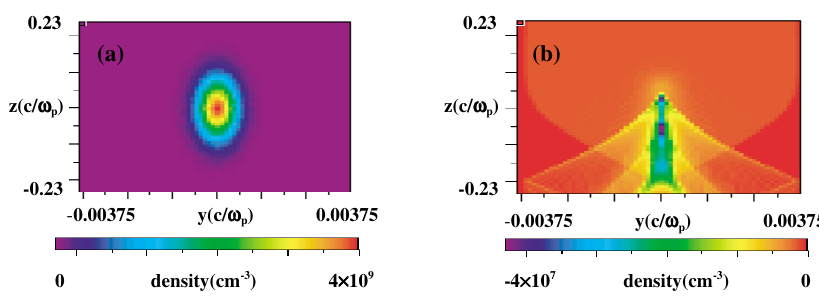
FIG. 3. (Color) (a) Positively charged beam density. (b) The corresponding cloud density. Cloud compression on the axis of the beam is evidenced from this figure. The color bars show the beam and cloud densities. The unperturbed (uniform density) cloud is 5.3 density is 10 6 cm (cid:3) 3 and c=! p